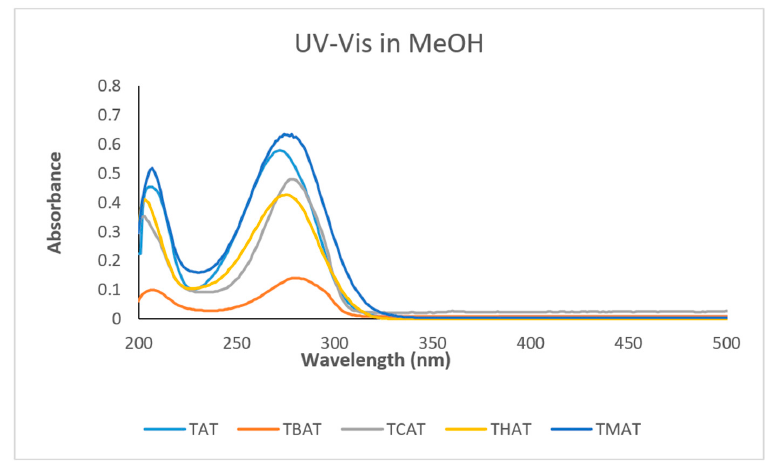
Figure 1. UV-Vis spectrum of sym -2,4,6-trisubstituted s -triazine derivatives (TXAT) in methanol.